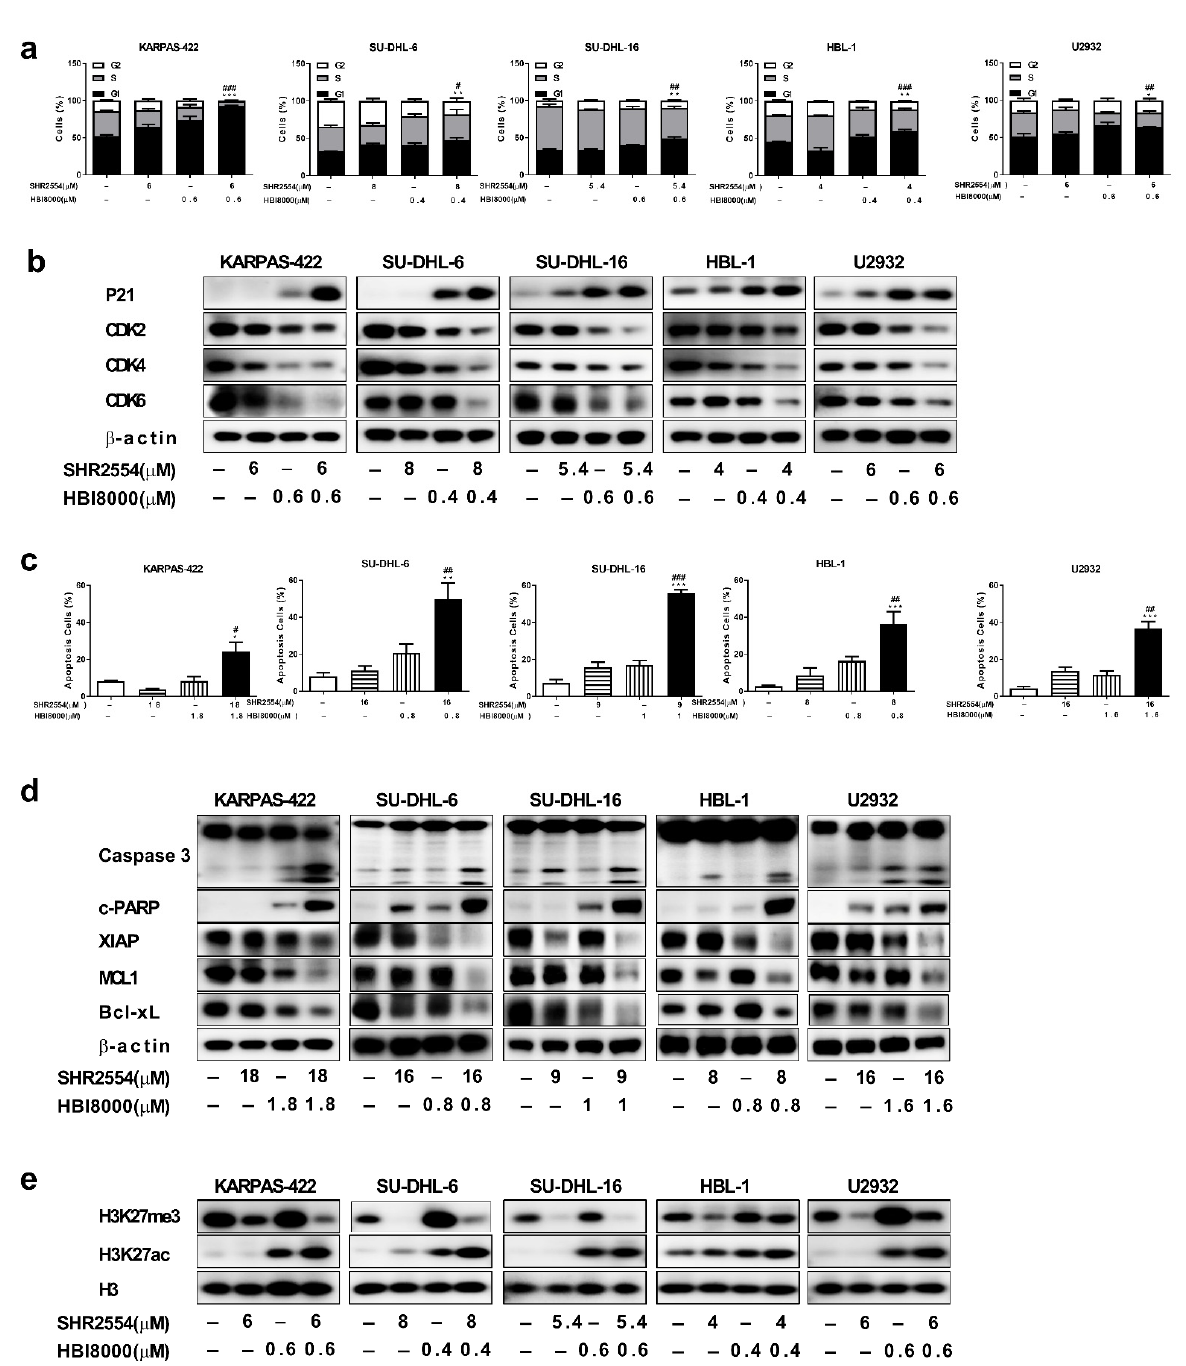
Figure 2. Synergistic effect of SHR2554 and HBI8000 on induction of cell death in DLBCL cell lines. ( a ) Concentrations of SHR2554 and HBI8000 were used for drug combination according to their 72 h IC 50 s in different cell lines and for each cell line, the ratio of SHR2554/HBI8000 was fixed. Cells were treated with indicated concentrations of SHR2554 or HBI8000 for 72 h and cell viability was measured by Cell Titer-Glo luminescent cell viability assay. Inhibition rates were calculated by (1 − dosing/vehicle) × 100%. ( b , d ) Combination index was calculated by CalcuSyn software and CI values < 1 was considered to be synergistic. ( c ) Concentrations of SHR2554 and HBI8000 were used for drug combination according to their 144 h, 72 h IC 50 s, respectively, and the ratio of SHR2554/HBI8000 was fixed. Cells were treated with SHR2554 for 72 h first and co-treatment of SHR2554 and HBI8000 for an additional 72 h. Data are expressed as mean ± SD of three independent experiments. S: SHR2554; H: HBI8000; Combo: SHR2554 combined with HBI8000.